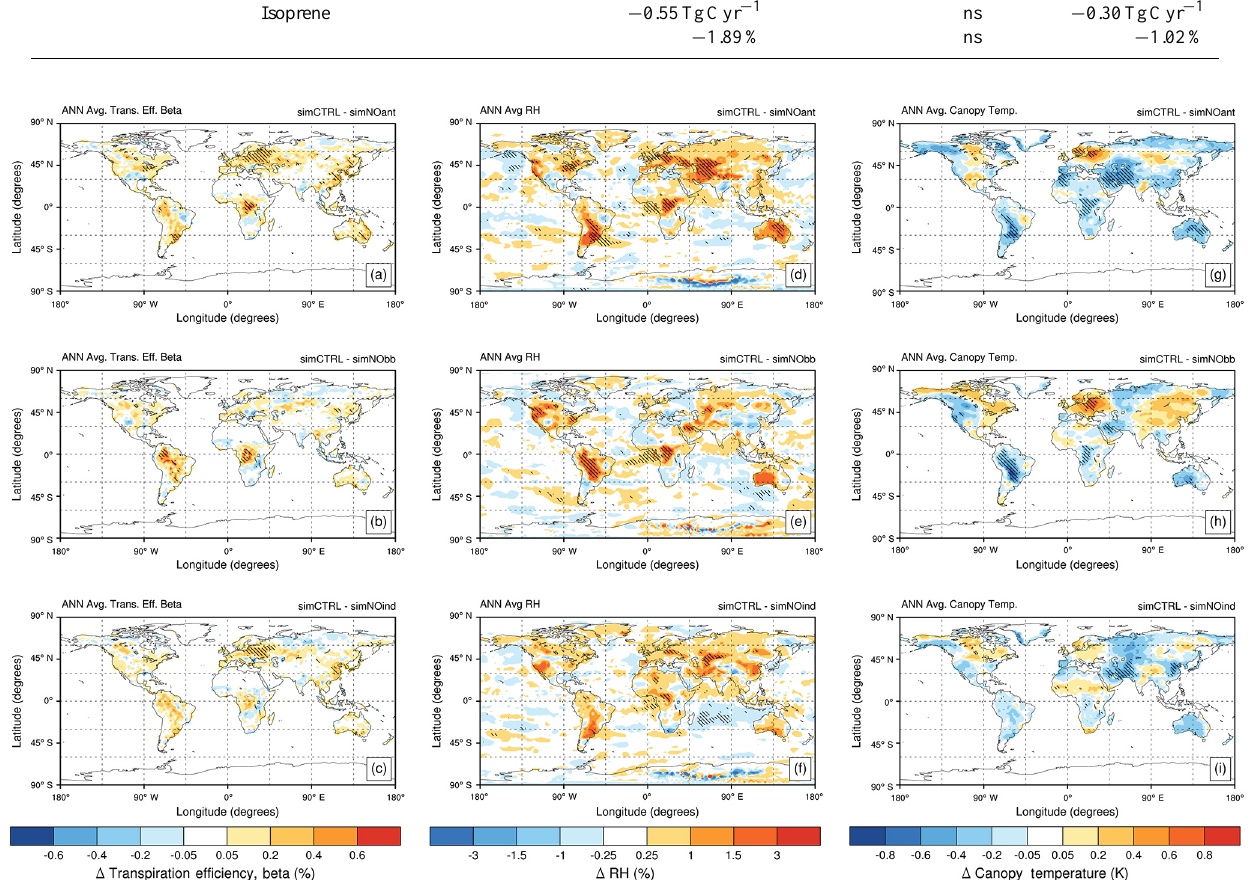
Figure 5. Spatial distribution of annual absolute change in transpiration efficiency (beta, in %; left column panels), surface relative humidity (RH, in %; middle column panels), and canopy temperature (in K; right column panels) between the control experiment (SimCTRL) and sensitivity experiments: (a, d, g) without all anthropogenic emissions (SimNOant); (b, e, h) without biomass burning emissions (SimNObb); and (c, f, i) without anthropogenic emissions except biomass burning (SimNOind). All experiments are set in a present-day climatic state. Shaded regions indicate areas where changes are significant at the 95% confidence